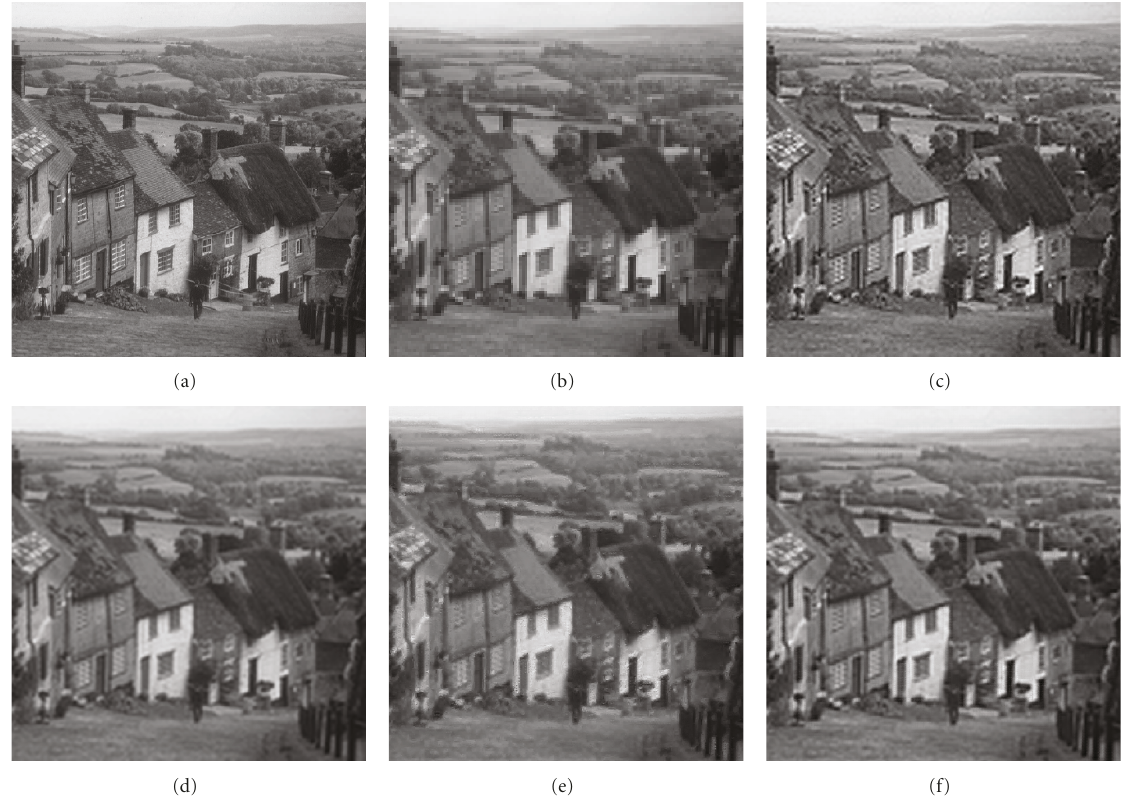
Figure 5: Subjective performance comparison between the proposed method and the conventional methods (the magnification factor was set to four): (a) original HR image “Goldhill” (512 × 512 pixels), (b) LR image (128 × 128 pixels), (c) HR image estimated by the proposed method, (d) HR image estimated by the interpolation using Lanczos filter, (e) HR image estimated by [10], and (f) HR image estimated by